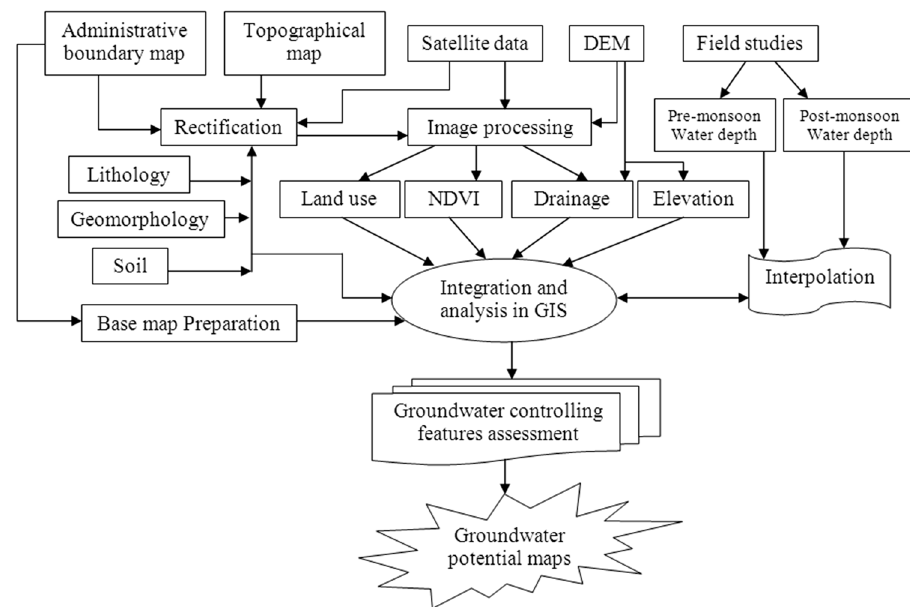
Fig. 2 Flowchart showing data and methods employed in delin- eating groundwater recharge potential